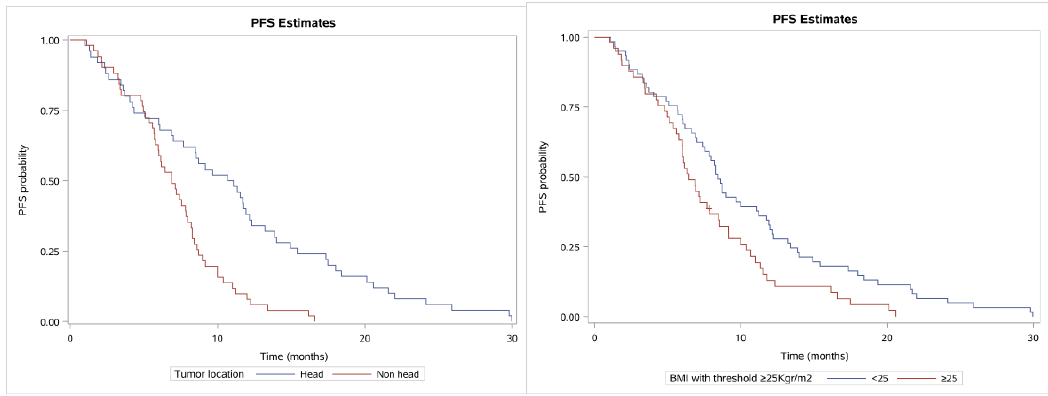
Figure 4. Kaplan – Meier curves showing PFS. ( left ) Patients with tumor location at the pancreas head vs. elsewhere (non-head) and ( right ) BMI with cut-off of 25 (normal vs. overweight).